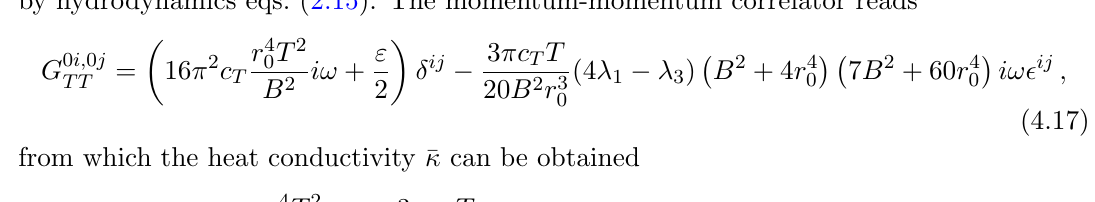
Figure 3 . Function (cid:27) t in (4.21) as a function of B=T 2 (continuous red line). Brown dashed line shows the high T behaviour (cid:27) t = B 2 =T 4 . Blue dashed line represents (cid:27) t = sector the current-current and current-momentum correlators satisfy the relations